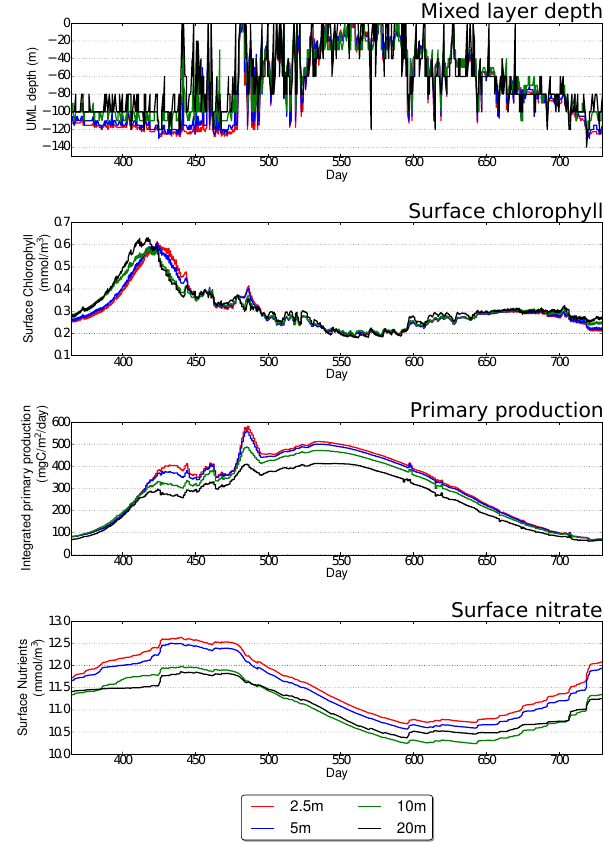
Fig. 5. Summary of simulated physical and biological behaviour at Station India for a uniform (2.5m), non-adaptive simulation. From top to bottom, panels show MLD, surface chlorophyll, integrated primary productivity and surface nutrients. Where available, mea- sured data are shown as green squares. Measured data are plotted against day of year due to lack of data for some quantities.